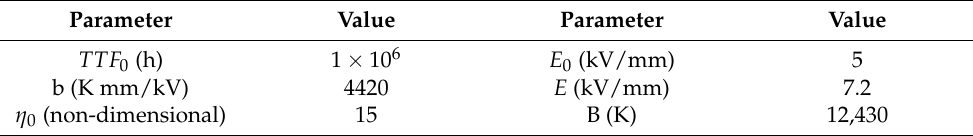
Table 3. The general parameters for IPM lifetime estimation